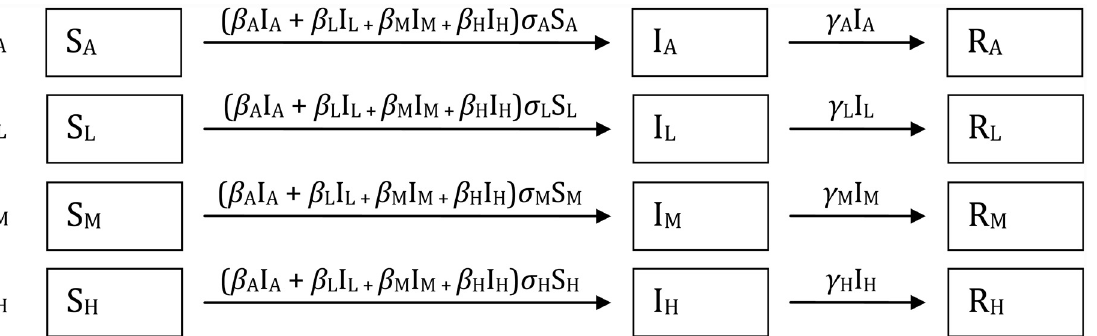
Fig 1. Influenza model with four levels of infection severity: asymptomatic (A), low-level symptoms (L), moderate symptoms (M) and hospitalised